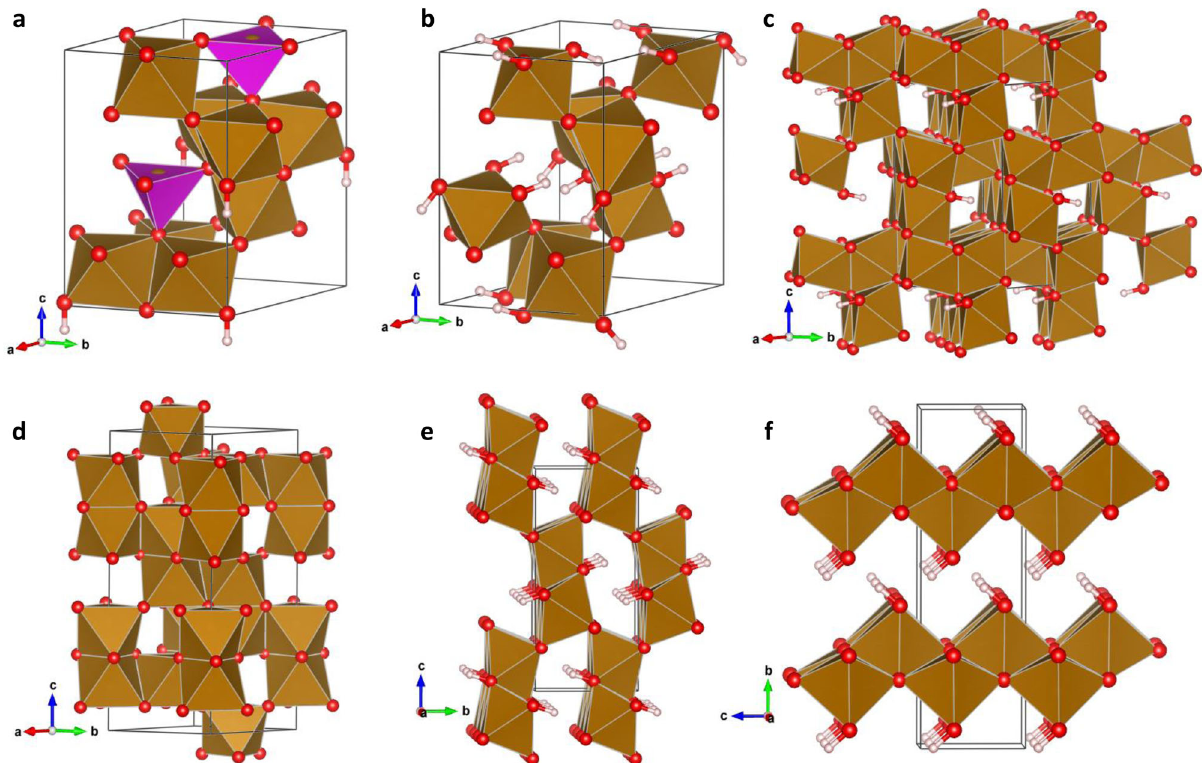
Fig. 1 Visual representation of the mineral phases investigated. a Michel model for ferrihydrite. b Manceau model for ferrihydrite. c Orthorhombic phase. d Hematite. e Goethite. f Lepidocrocite.